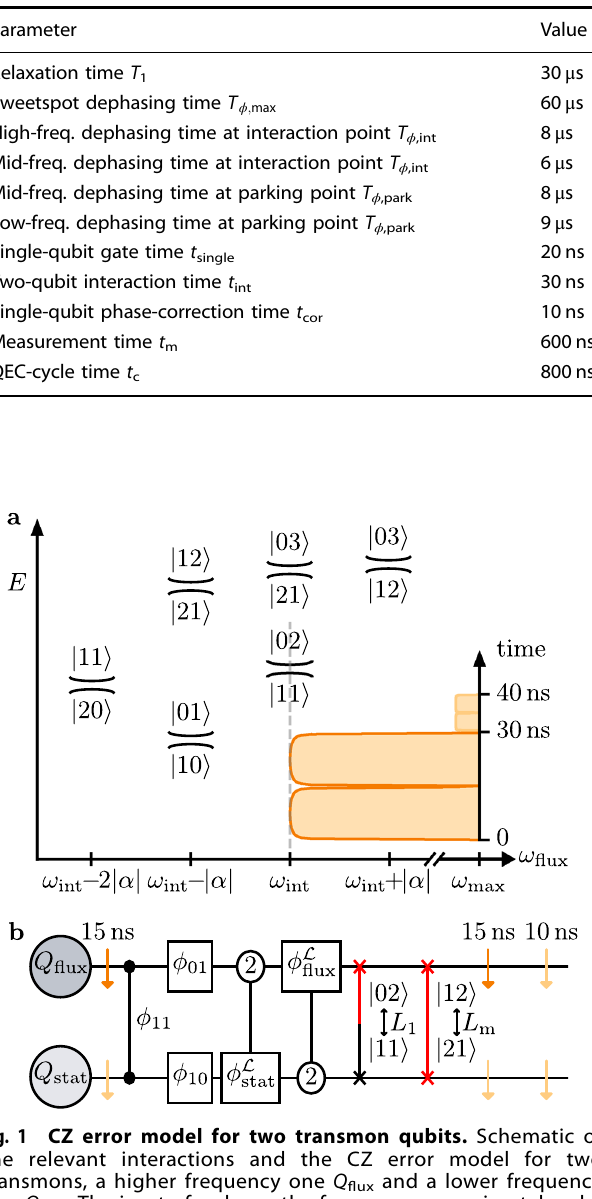
Table 1. The parameters for the qubit decoherence times and for the gate, measurement and QEC-cycle durations used in the density- matrix simulations.